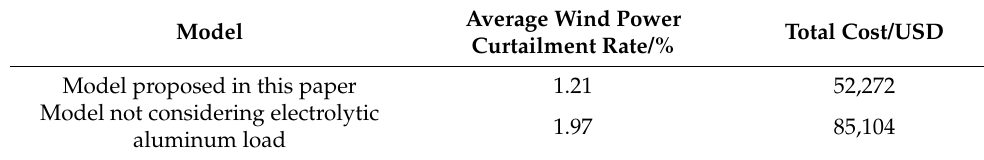
Table 2. The results comparison between different models.